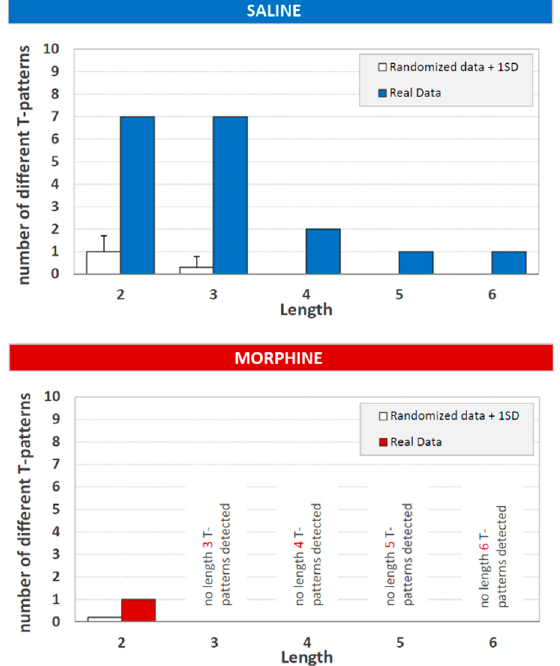
Figure 2. T-pattern length distribution in real data (filled bars) and randomized data + 1 SD (white bars), in control (saline) and morphine (12 mg/kg in a volume of 1 mL of saline) injected groups. X-axis = T-pattern length, i.e., number of events in the T-pattern’s structure; and Y-axis = number of different T-patterns detected. Data obtained from the analysis of two groups each encompassing 10 subjects.